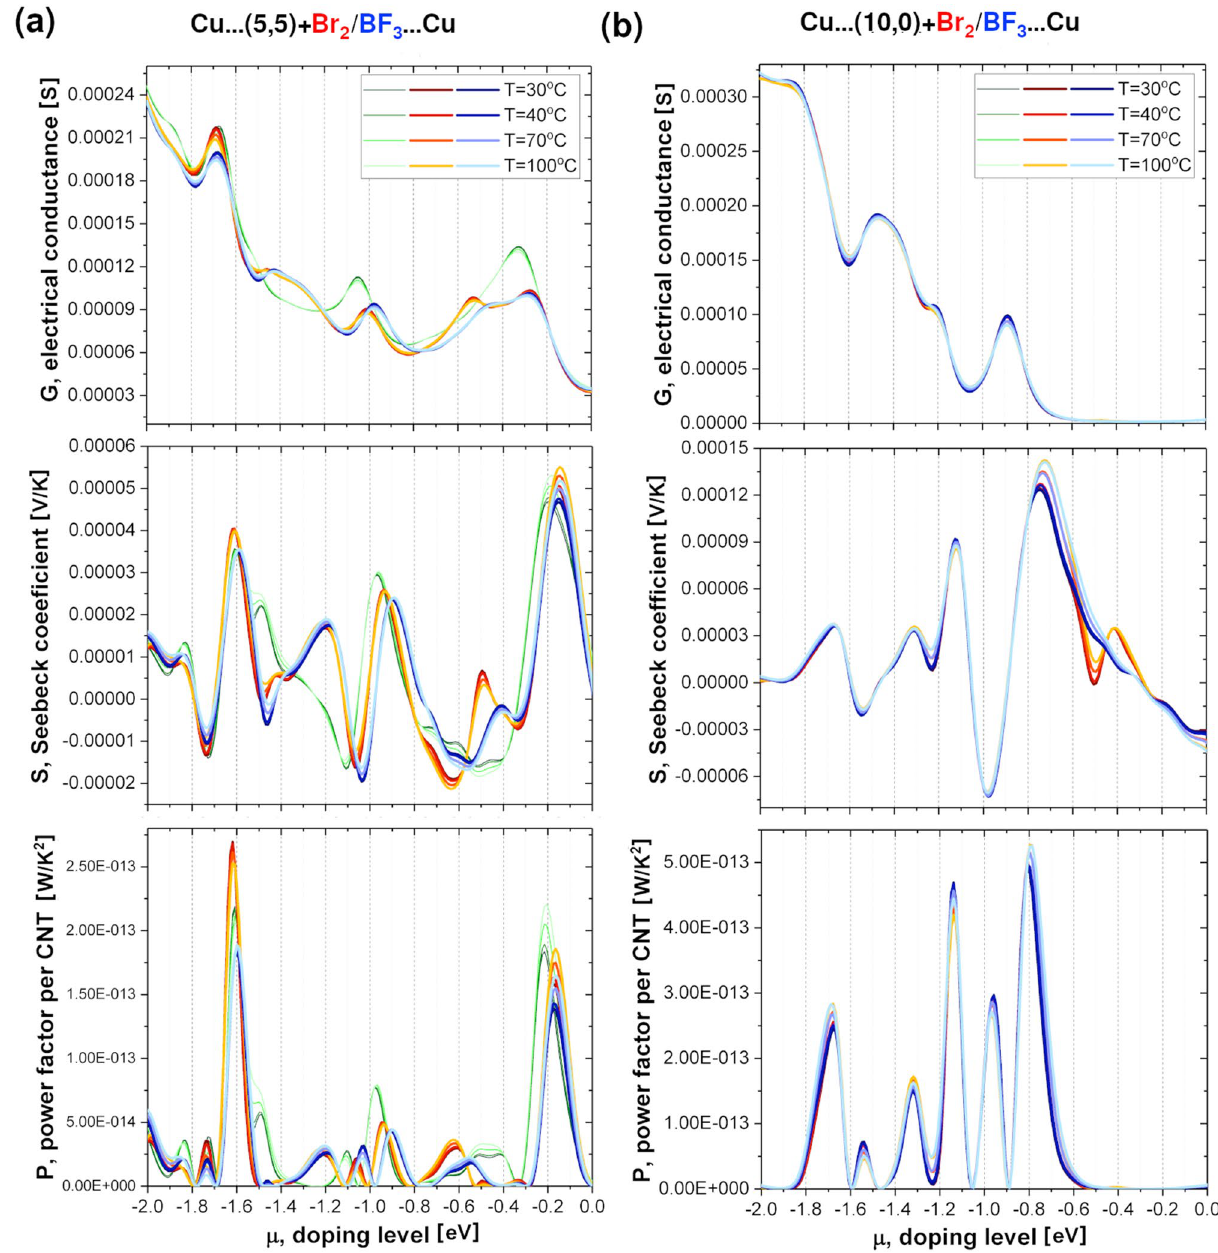
Figure 11. Computed thermoelectric properties of Br 2 (red–orange lines) and BF 3 (blue lines) doped ( a ) metallic (5,5) and ( b ) semiconducting (10,0) CNTs sandwiched between Cu electrodes. Conductance (G), Seebeck coefficient (S) and Power Factor per CNT (P) are plotted as a function of doping level (μ) for four different temperatures: 30, 40, 70, and 100 °C. Thermoelectric properties of pristine CNTs (green lines) are shown as a